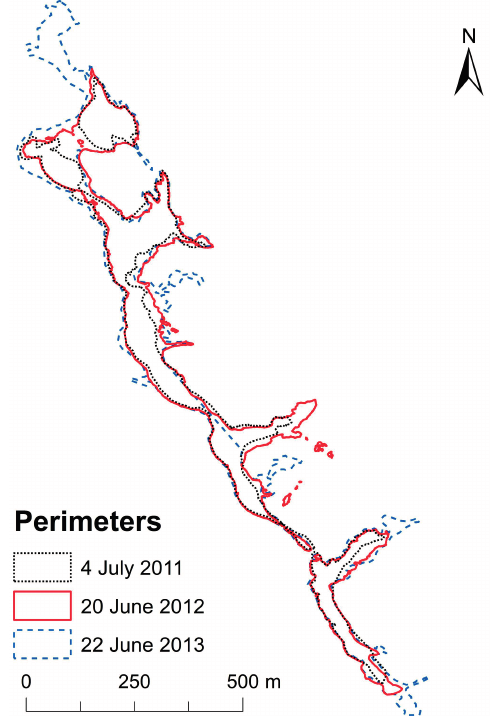
Figure 7. A comparison of the perimeters of snow field Level 01 mapped in 2011, 2012 and